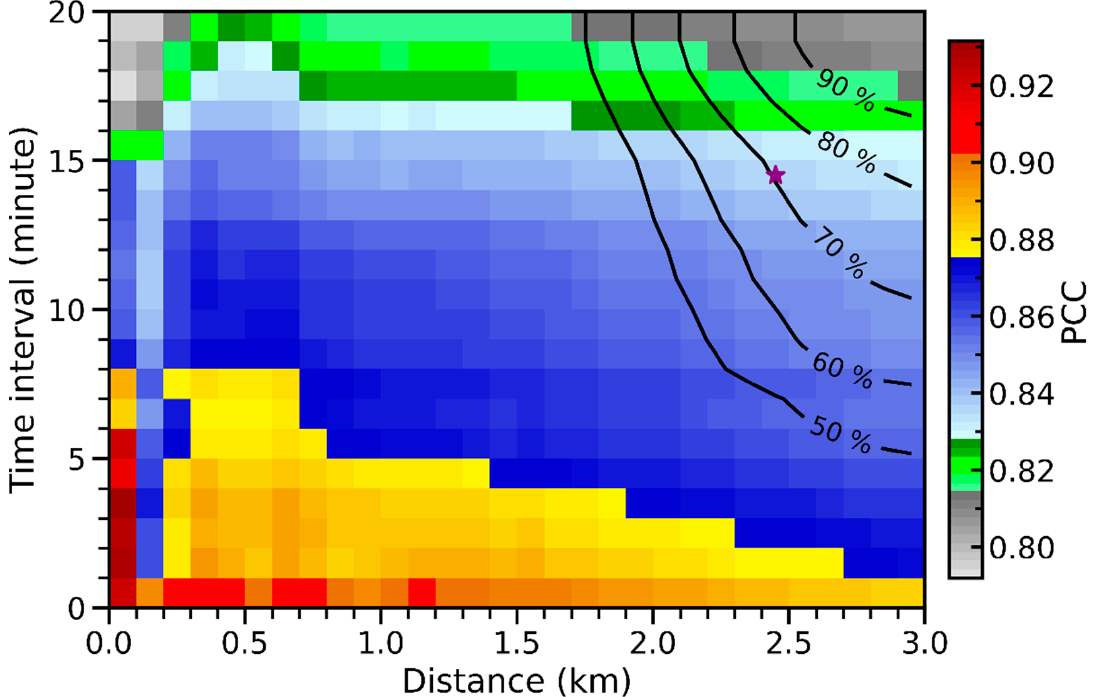
Figure 1. The matrix of Pearson correlation coefficients (PCCs, shaded) and the percentage of coincident Topht20s (contours, begins at 50%), as a function of distance and time interval between the TRMM_PR and GPM_KuPR. The resolutions of distance and time interval are 0.1 km and 1 min, respectively. The purple star represents the criteria in this study.